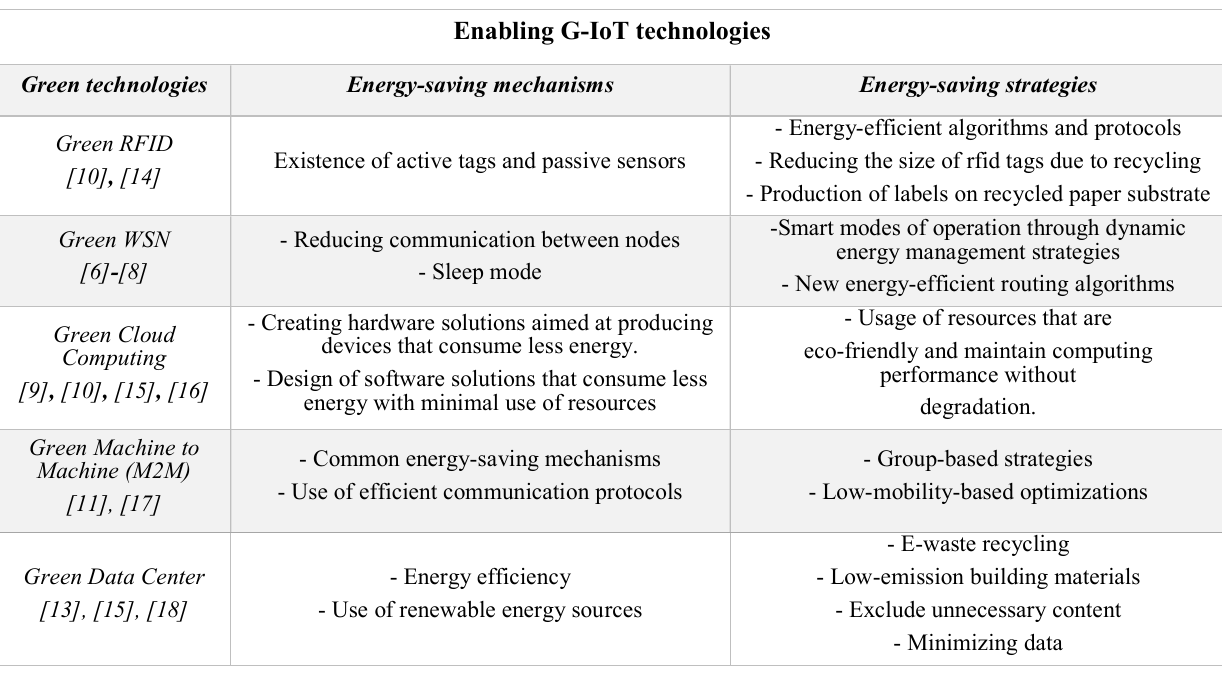
Table 1. Green strategies and mechanisms for